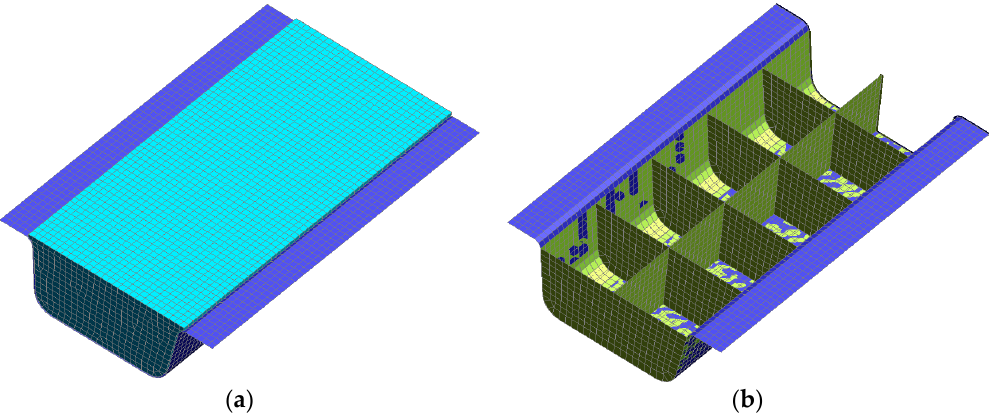
Figure 8. Reinforcement approaches. ( a ) Foam core filling. ( b ) Polypropylene reinforcement.